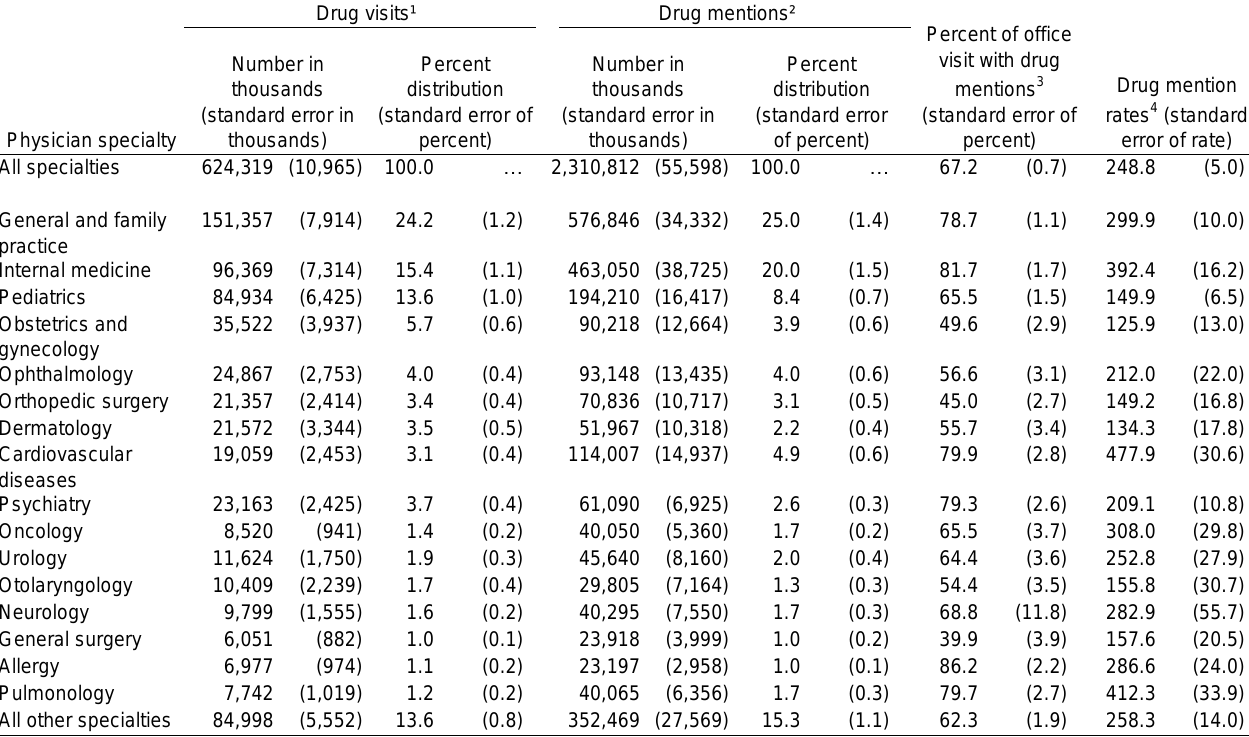
...Category not applicable. 1 Visits at which one or more drugs were provided or prescribed.